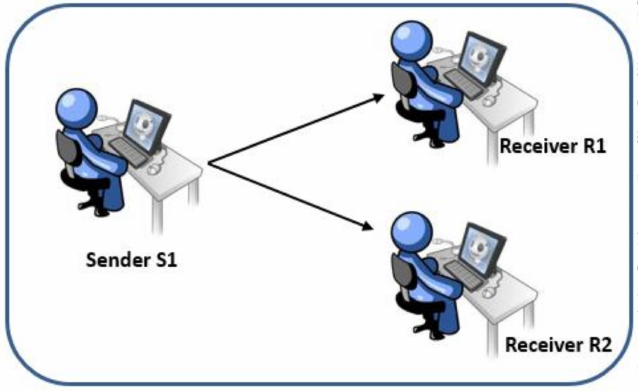
Figure 4. Topology with one sender and two